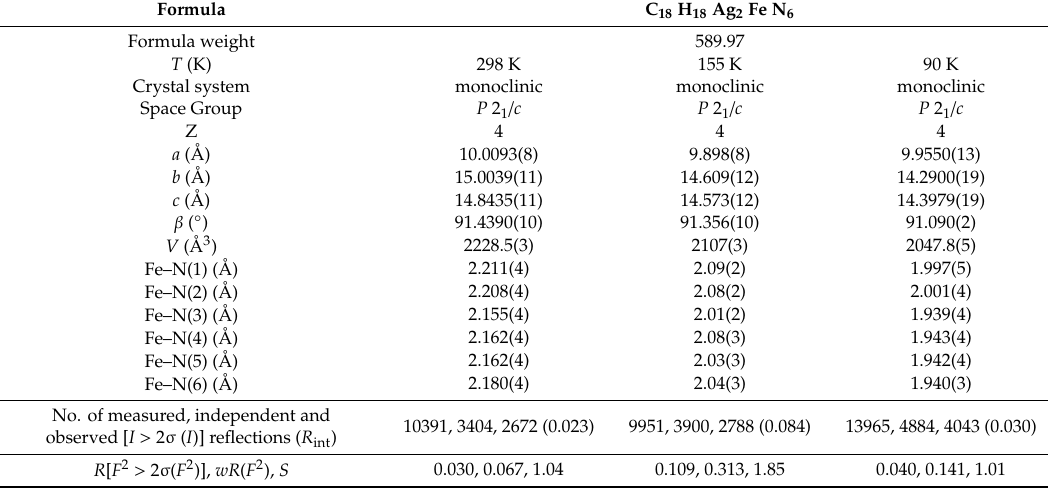
Table 1. Crystallographic data for Fe(3,4-dimethyl-pyridine) 2 [Ag(CN) 2 ] 2 at di ff erent